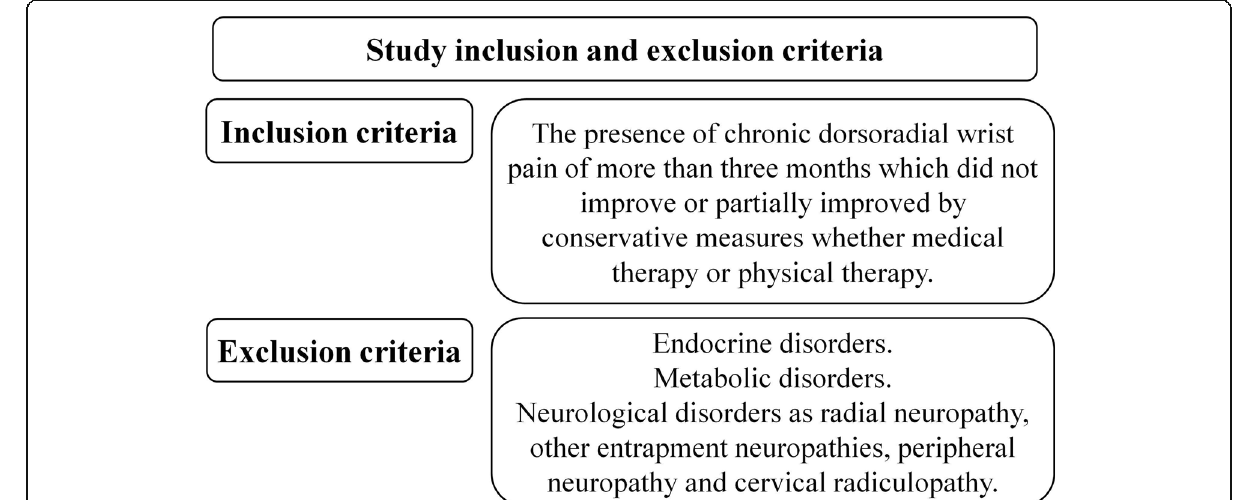
Fig. 3 The inclusion and exclusion criteria of the